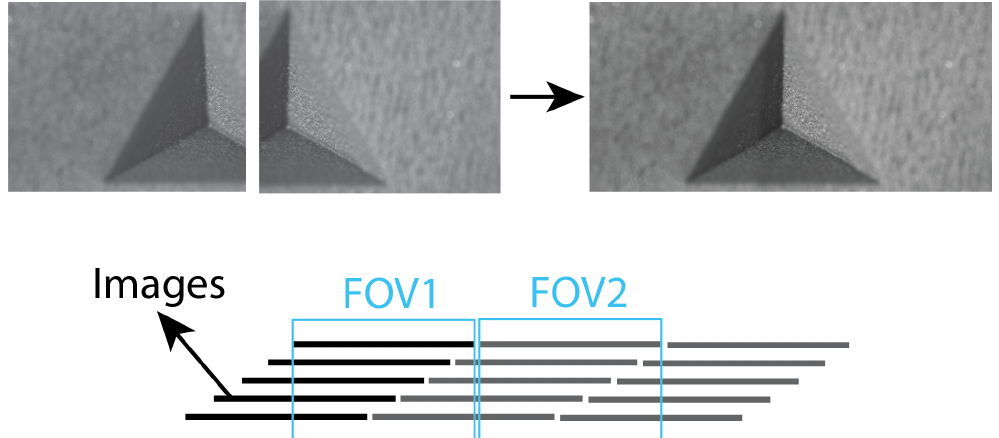
Figure 6. Stiching images of multiple stacks using phase correlation before focus measuring for full FOV measurements.